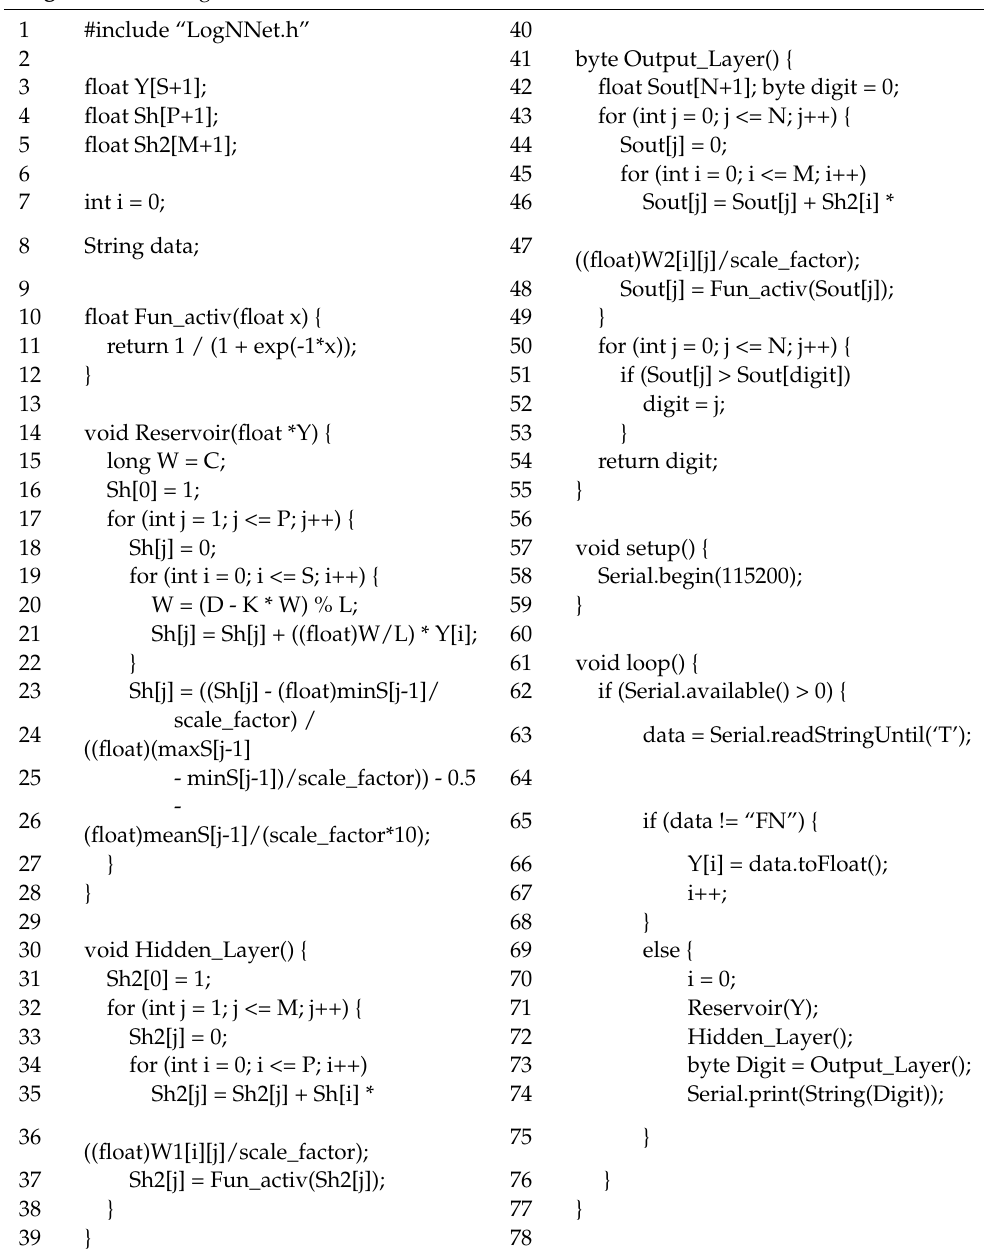
Algorithm A1. LogNNet neural network executable code on Arduino Nano